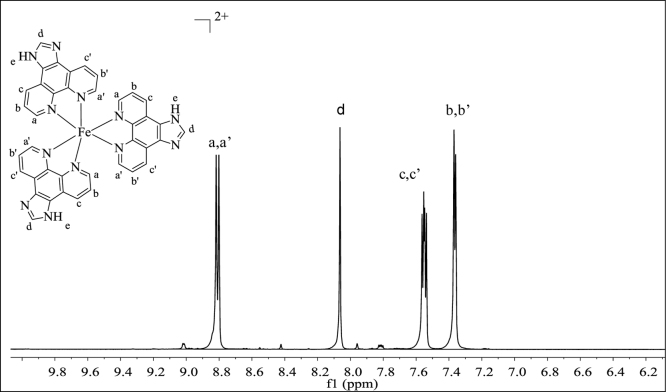
1H NMR spectrum (500 MHz) of complex 3 in dimethylsulfoxide-d6.